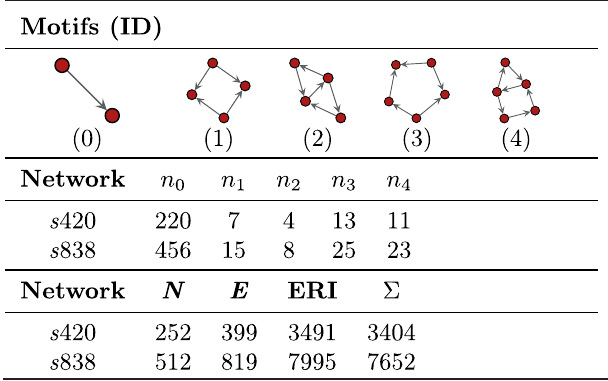
TABLE IV. The motifs of electronic circuits (digital fractional multipliers) obtained using all connected motifs up to size 5.